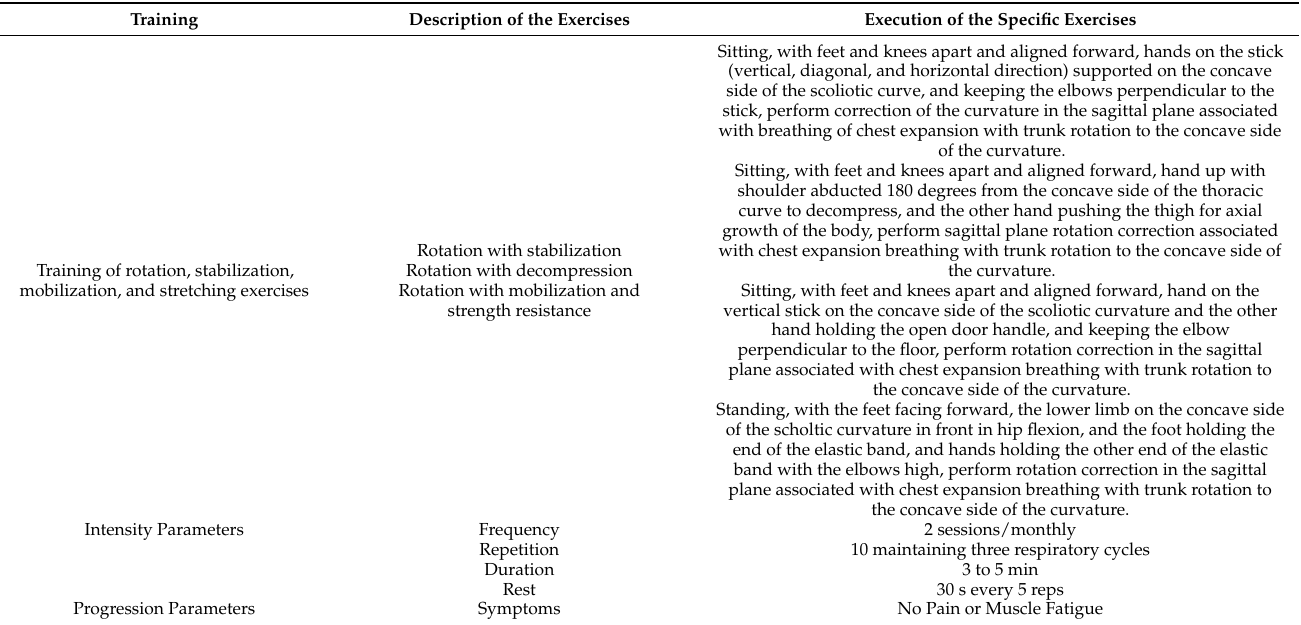
Table 2. Intervention protocol with specific rotation, stabilization, mobilization, and stretching exercises for adolescents with idiopathic scoliosis (AIS).